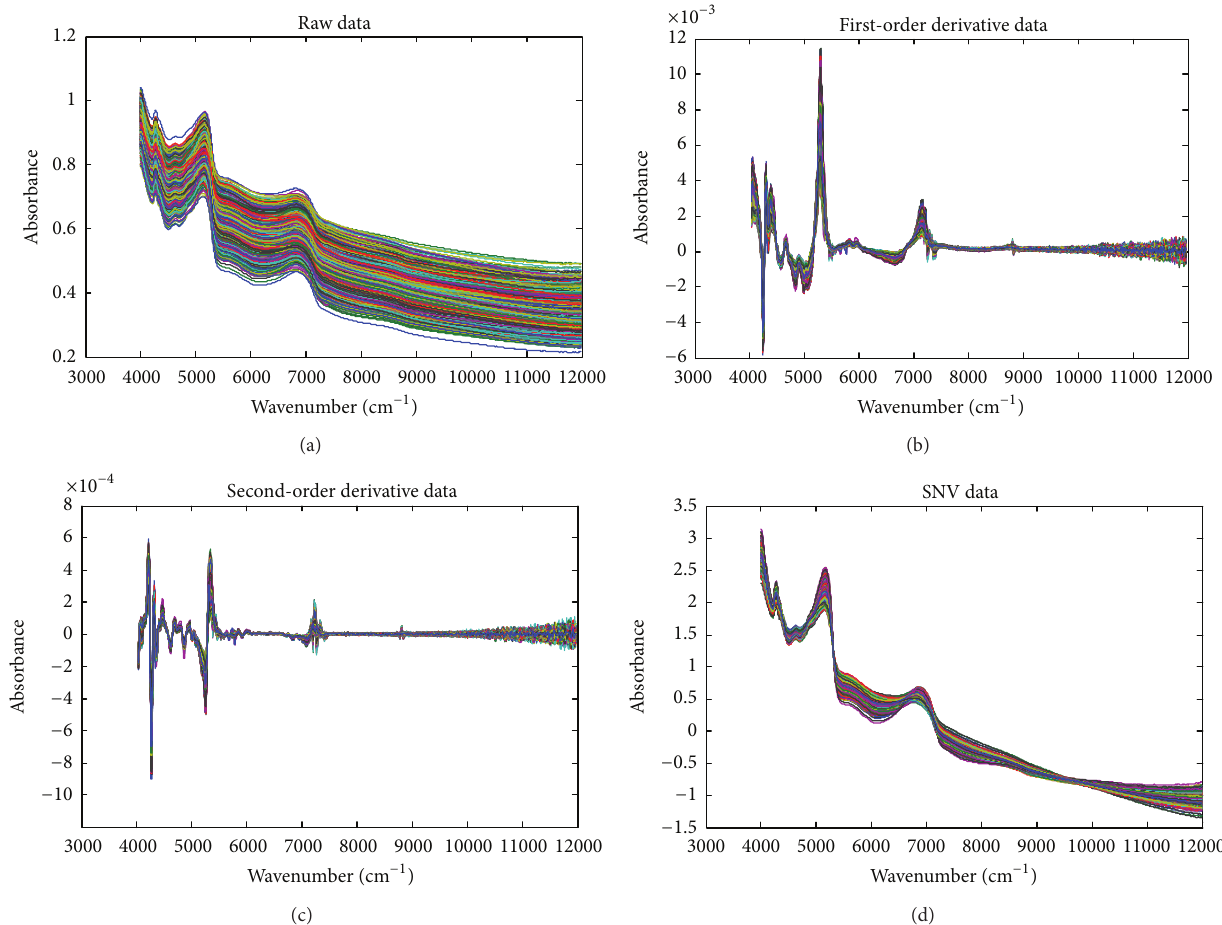
Figure 1: Some of the raw, first-order derivative, second-order derivative and SNV spectra of 884 pidan